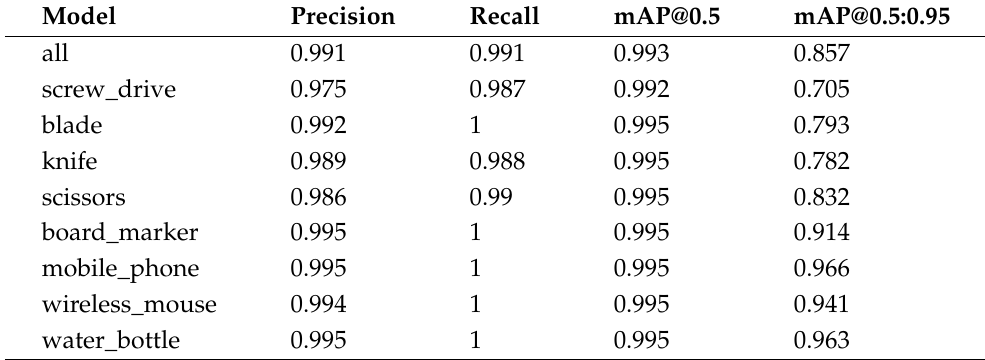
Table 3. Performance on each